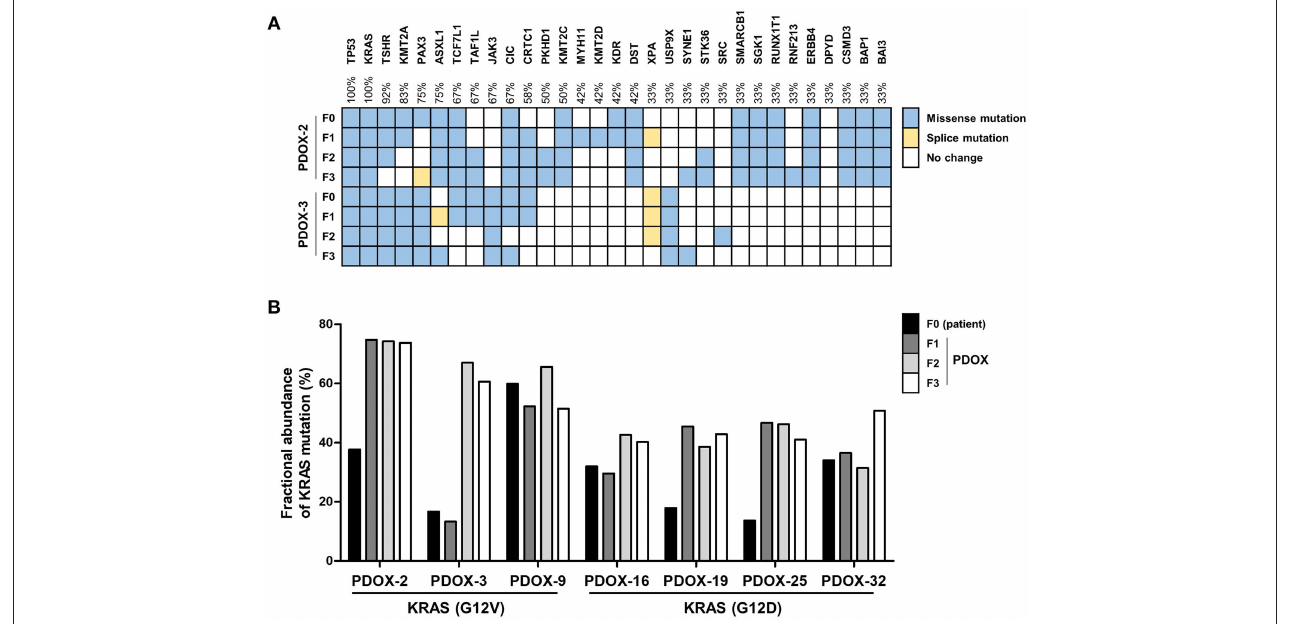
FIGURE 2 | Retention of genetic alterations between primary and PDOX tumors. (A) Heat maps depicting the overall mutations of a paired set of genes in PDOX-2 and PDOX-3 from CCP data. (B) Comparison of KRAS mutation fractional abundances from ddPCR that was used with specific primers for G12V or G12D mutation detection, between primary and passaged PDOXs tumors.